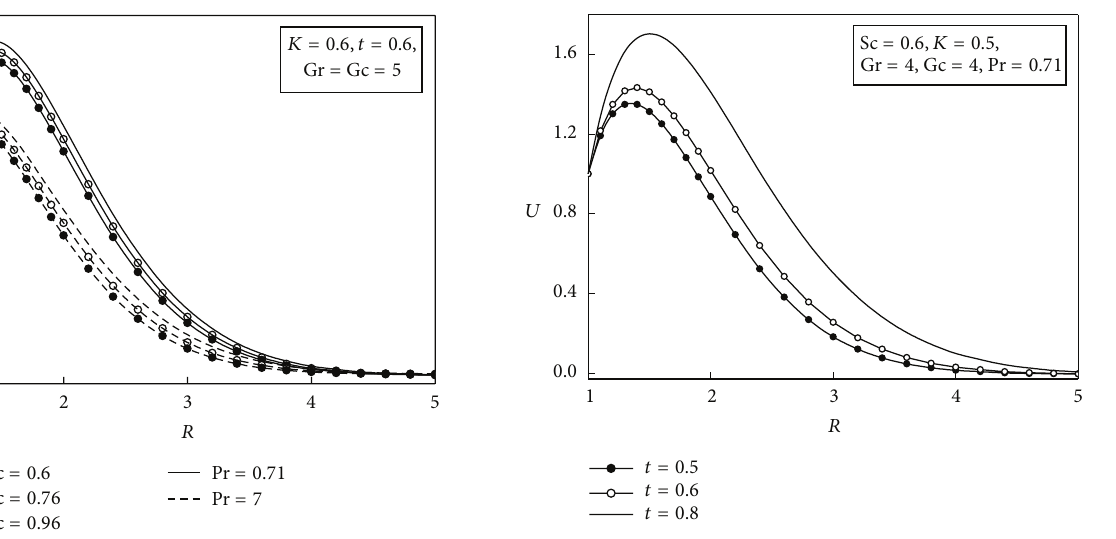
Figure 5: Effect of time on velocity profiles at 𝐾 = 0.5 , Gr = 4, Gc = 4, Sc = 0.6, and Pr =